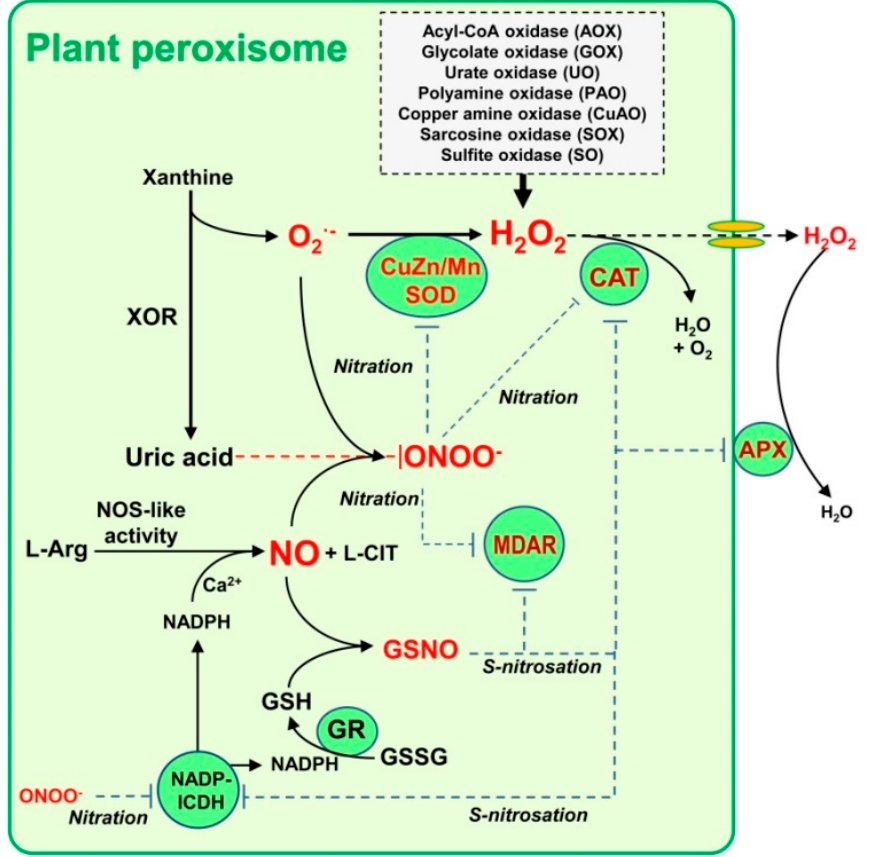
Figure 3. Working model showing the existing interactions between NO metabolism and reactive oxygen species in leaf peroxisomes based on available experimental data. Plant peroxisomes contain a team of H 2 O 2 -generating enzymes involved in diverse pathways. Xanthine oxidoreductase (XOR) activity catalyzes the conversion of xanthine to uric acid with the concomitant generation of superox- ide radical (O 2 •− ) which immediately dismutates to H 2 O 2 by the action of CuZn/Mn-superoxide dismutase (CuZn/Mn-SOD). Then, this H 2 O 2 is removed by catalase (CAT) activity. Additionally, a fraction of this H 2 O 2 can be decomposed by the membrane-bound ascorbate peroxidase (APX). An L-arginine (L-Arg) and Ca 2+ dependent NOS-like activity generates L-citrulline (L-CIT) plus NO. This NO interacts chemically with O 2 •− to generate peroxynitrite (ONOO − ), a strong nitrating compound that facilitates posttranslational modifications (PTMs) such as tyrosine nitration. But ONOO − can be simultaneously scavenged by the uric acid formed through the XOR activity (dashed red line). NO may react with reduced glutathione (GSH) to produce S -nitrosoglutathione (GSNO), a NO donor which facilitates S -nitrosation. GSH is restored by glutathione reductase (GR) which needs NADPH provided by several NADPH-generating enzymes (NADPH-ICDH, G6PDH and 6PGDH). Uric acid is an ONOO − scavenger which allows controlling the effect of NO metabolism. Among the peroxisomal targets of NO-derived PTMs identified so far (see Table 2) it is remarkable that CAT, CuZn-SOD and monodehydroascorbate reductase (MDAR) can undergo an inhibitory effect either by nitration or S -nitrosation. The dashed blue line denotes an inhibitory effect. Modified from [54].